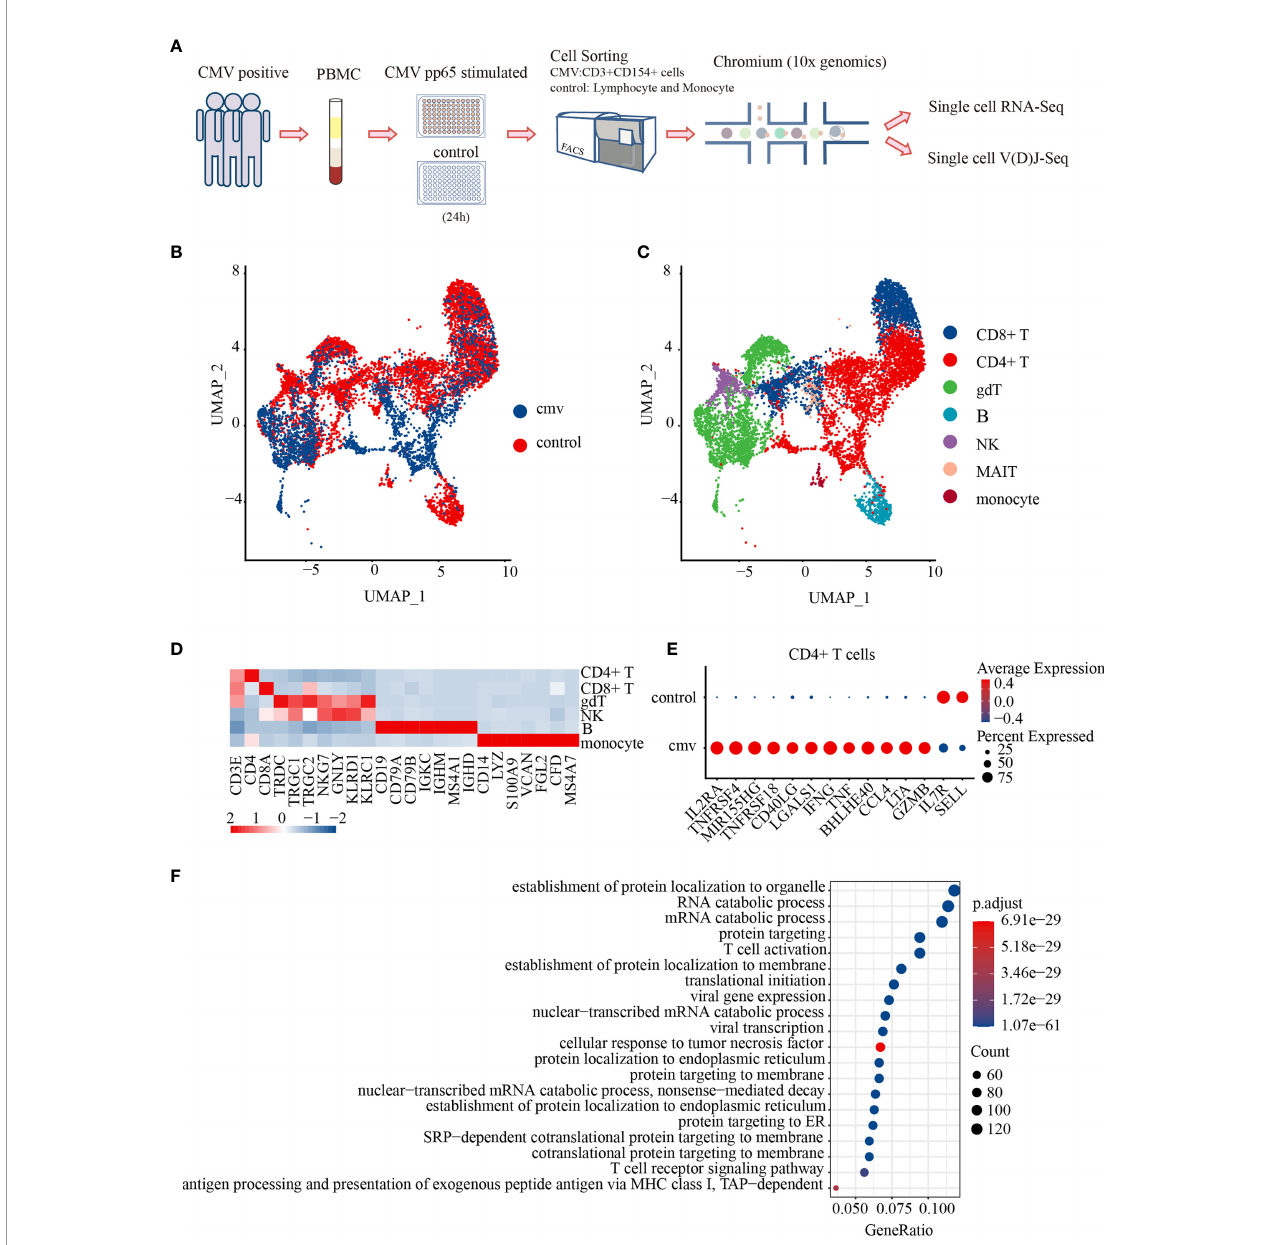
FIGURE 1 | Characterization of the antiviral pro fi les of CMV pp65-speci fi c CD4+ T cells. (A) Experimental work fl ow for single-cell analysis of CD4+ T cells from PBMC of three donors. Cells stimulated in vitro with CMV pp65 were cultured and sorted, with reactivated CMV-stimulated T cells gated for CD3+CD154+, and control monocytes and lymphocytes gated for FSC-SSC, followed by 5 ′ single-cell RNA and paired T-cell receptor sequencing. UMAP embeddings of merged scRNA-seq pro fi les from control and CMV-stimulated immune cells were plotted and colored by (B) sample and (C) cell cluster. (D) Heat map of scaled mean gene expression of the major canonical markers (columns) detected in different cell types in merged CMV and control cells (rows). (E) Dot plot of differentially expressed genes (DEGs), showing both the levels of expression and the percentages of CD4+ T cells in CMV and control samples. (F) Gene Ontology (GO) analysis of DEGs in CMV and control CD4+ T cell samples. The Top 20 enriched GO terms are ordered on the y-axis. The x-axis represents the gene percentage in enriched GO terms. The sizes of the dots represent the number of genes included in each GO term. The color gradient of dots represents the adjusted p-values of each enriched GO